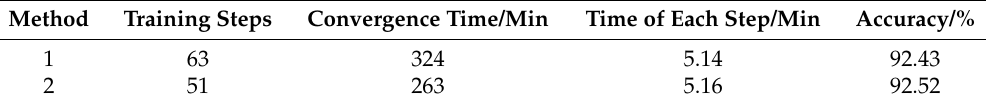
Table 2. Convergence time and accuracy using two back-propagation